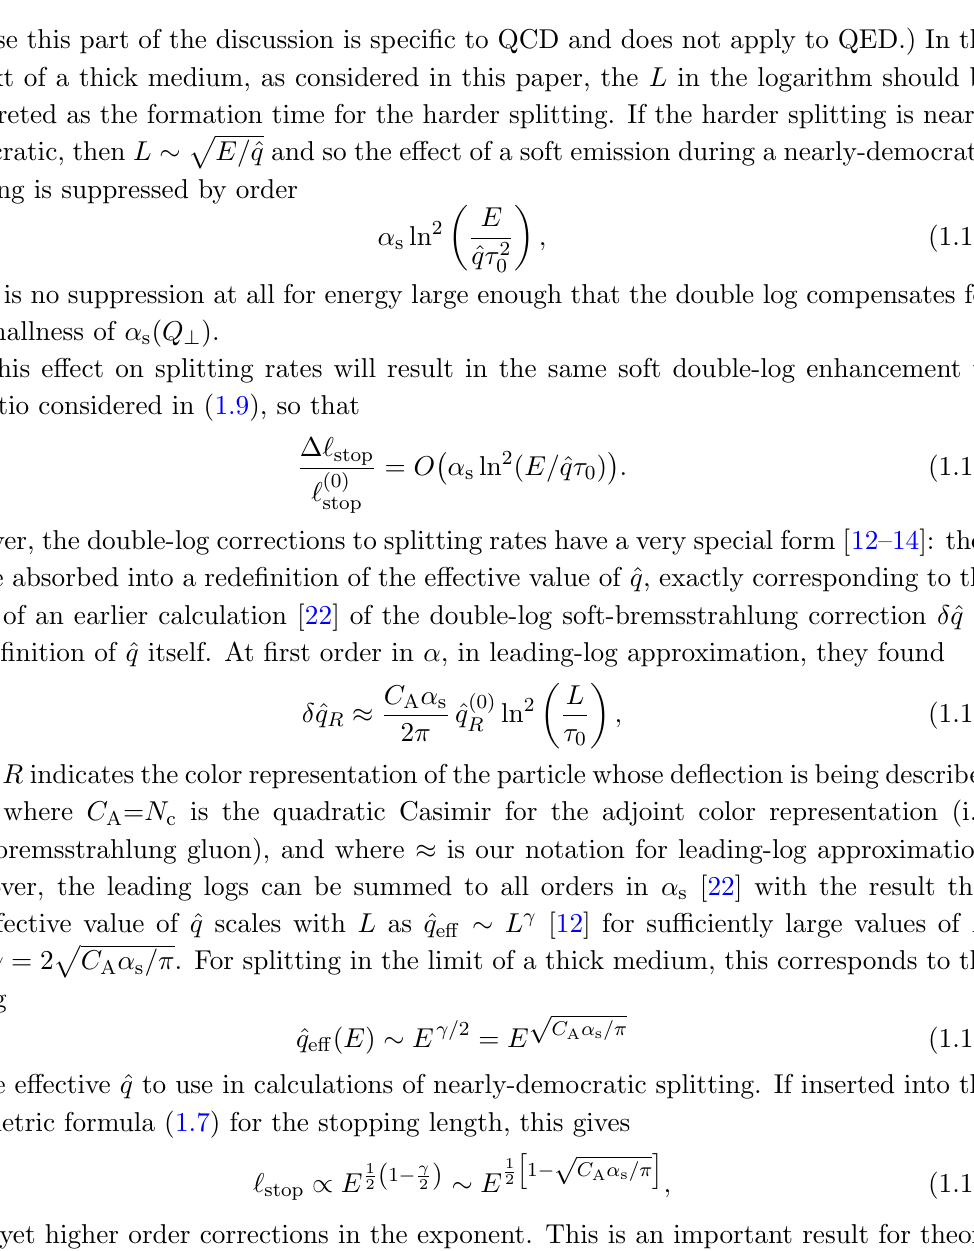
Figure 5 . An example of overlapping formation lengths associated with soft gluon emission from a harder bremsstrahlung gluon. For QCD, softer gluon emission corresponds to shorter formation lengths (the green region) than harder gluon emission (the magenta region). This type of process contributes to the double logarithm in